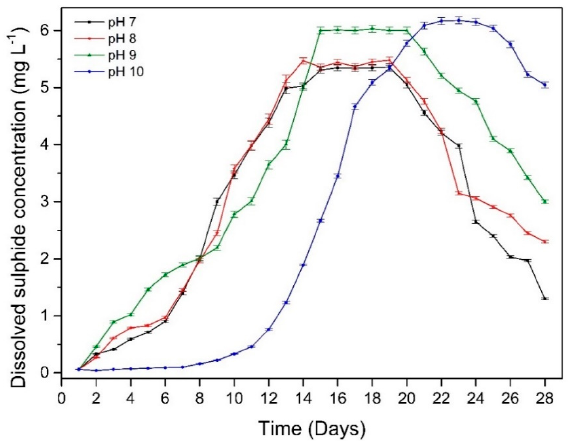
Figure 2. Dissolved sulphide levels over time for samples at different starting pH.